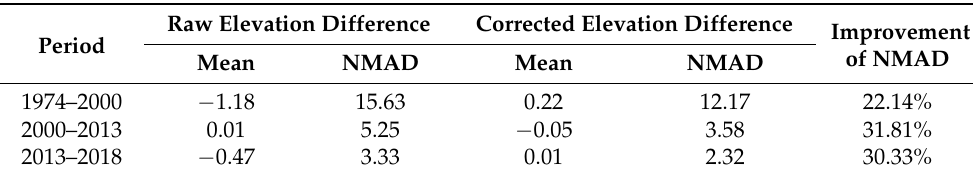
Table 3. Statistical results of elevation difference in stable regions before and after DEM co-registration and systematic bias